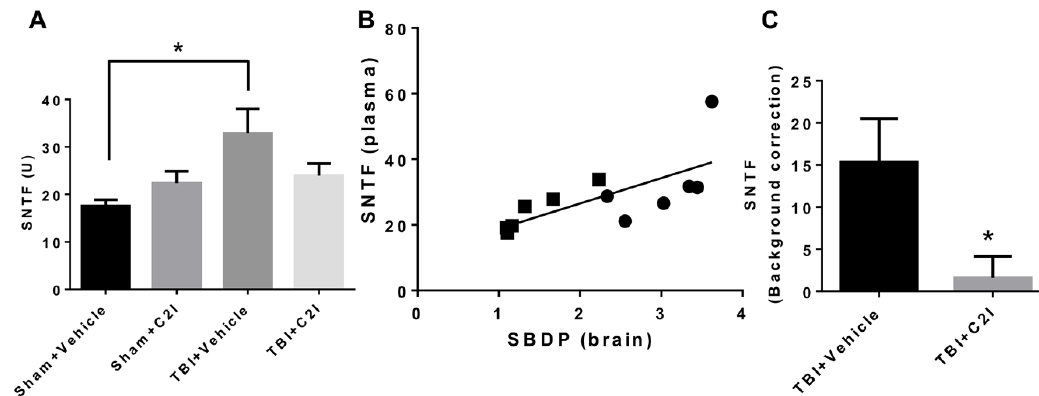
Figure 5. Levels of Spectrin N-Terminal Fragment (SNTF) in mouse blood 24 h after TBI with or without treatment with calpain-2 inhibitor (C2I). ( A ) Levels of SNTF in plasma of CD-1 mice collected 24 h after TBI. C2I (0.3 mg / kg) or vehicle was injected intravenously 1 h after TBI. * p < 0.05. N = 4 for Sham + Vehicle and Sham + C2I. N = 6 for TBI + Vehicle and TBI + C2I. One way ANOVA followed by Bonferroni’s test. ( B ) Correlation between SNTF levels in plasma and SBDP levels in brain of CD-1 mice 24 h after TBI. Black circles: TBI + Veh; black rectangles: TBI + C2I. R = 0.70. ( C ) Increase in SNTF levels after TBI in plasma of CD-1 mice collected 24 h after TBI. SNTF levels after sham surgery (background SNTF level) were subtracted from SNTF levels after TBI. * p < 0.05. N = 6, t -test.